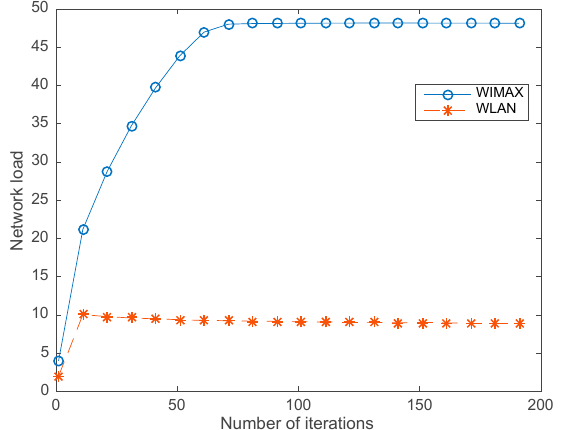
Figure 9. Network load with the number of iterations.